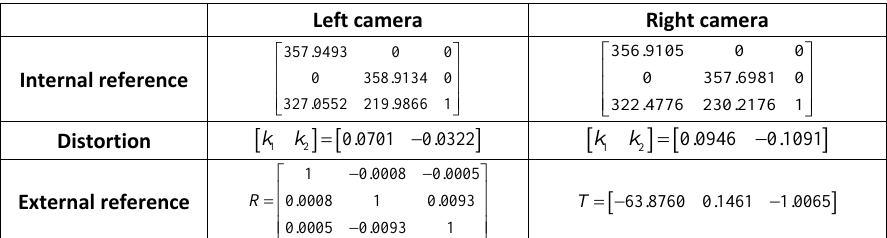
Table 1. Calibration